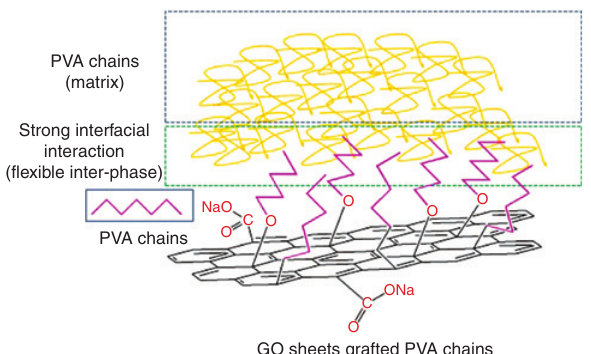
Figure 8: Schematic illustration of the hot-drawing orientation process of GO/PVA composite fibers in the amorphous region